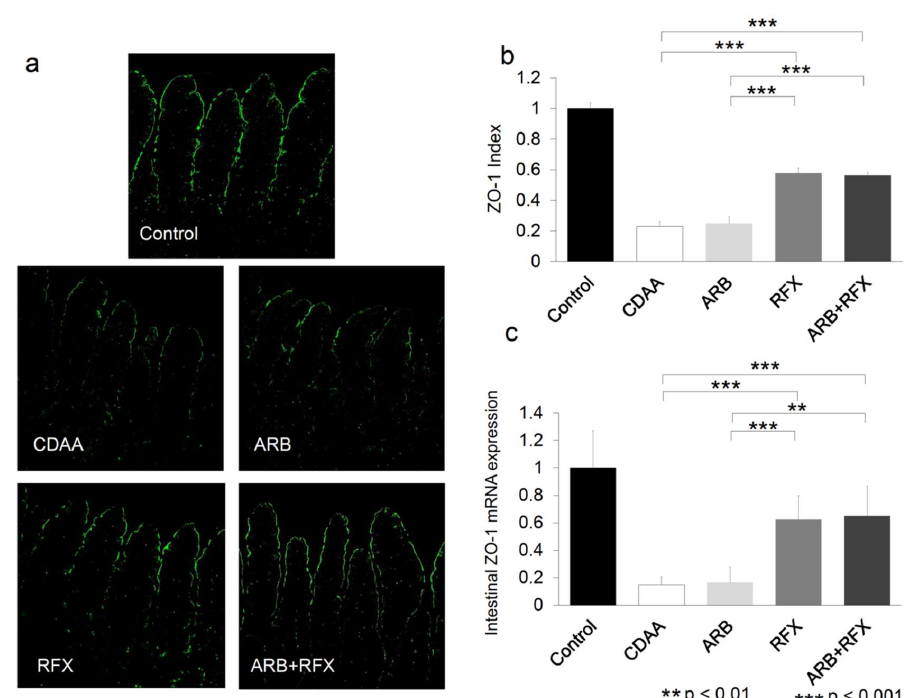
Figure 3. ( a ) Immunofluorescence microphotographs of intestinal ZO-1 expression. (magnification; 200 folds) ( b ) Semi-quantitative analysis of immunofluorescence of ZO-1 expression. ( c )